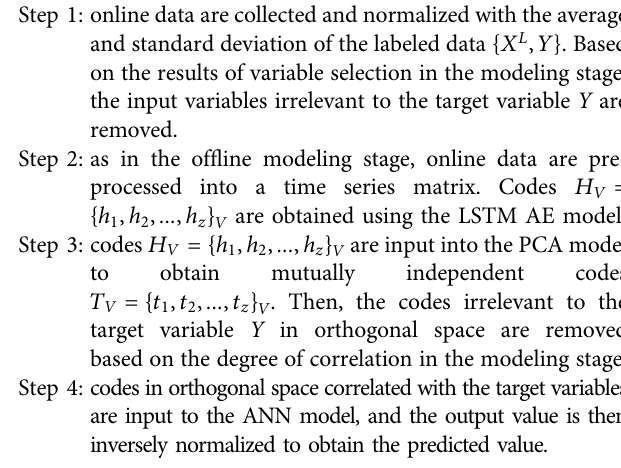
the ANN regression model, and 30% T L pca are used as validation data to obtain the key parameters of the model.